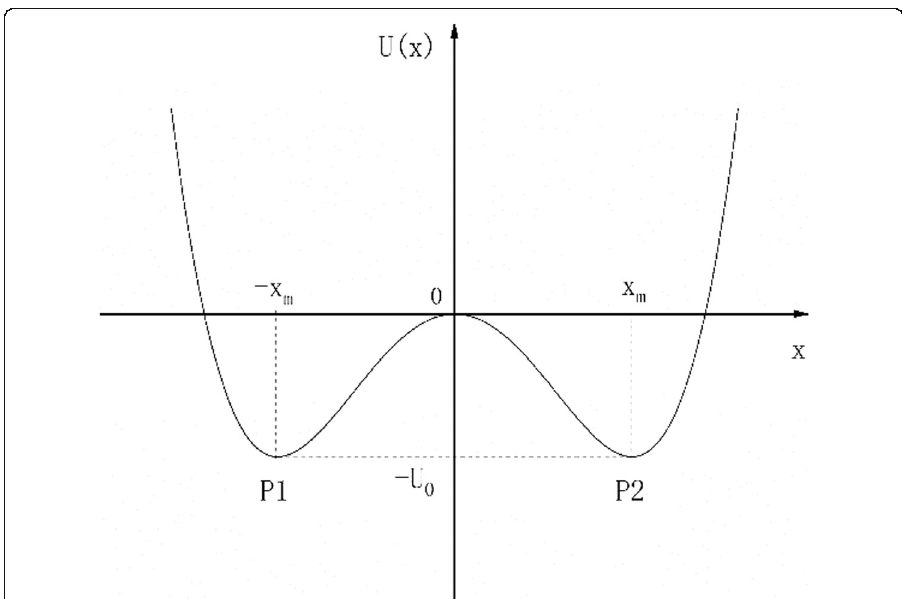
Fig. 1 The curve of potential function U ( x i